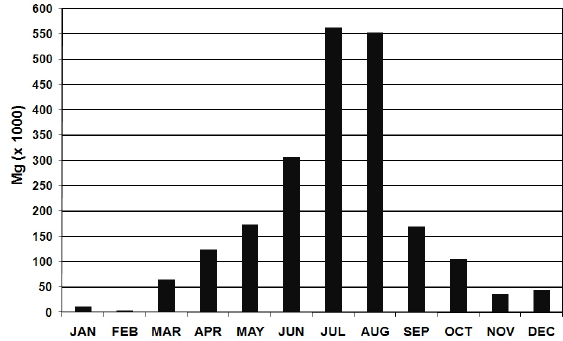
Fig. A3. Monthly domain-wide lightning NO total emissions for the 2002 natural emissions